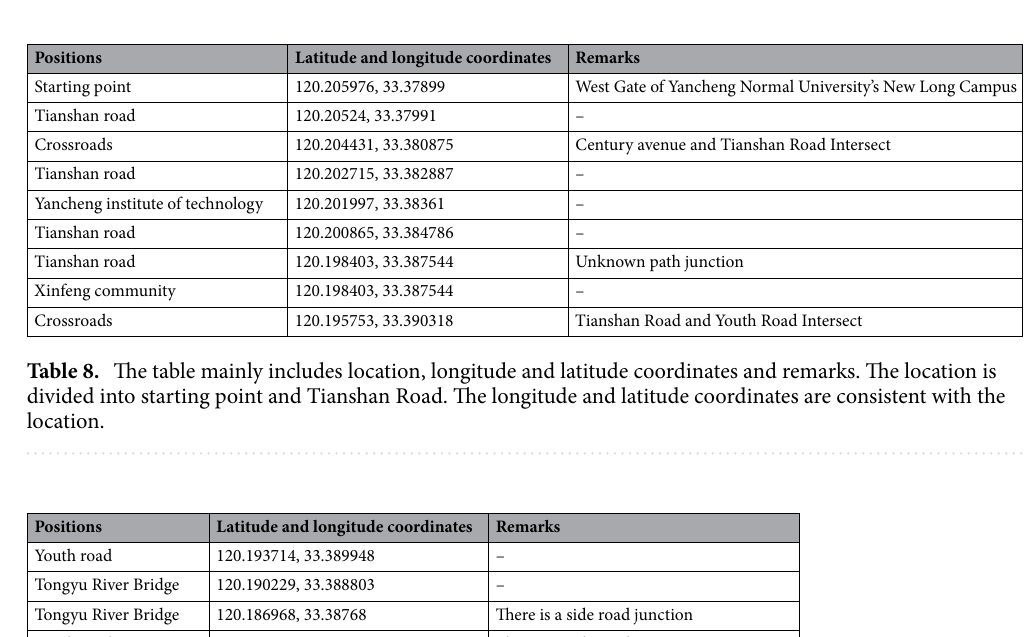
Figure 8. Simulation interface of CarSim. ( a ) Simulate vehicle operation by adjusting scene, road surface and definition, driving conditions, etc. ( b ) It shows the speed constraints of the simulation system output in the whole simulation driving process.